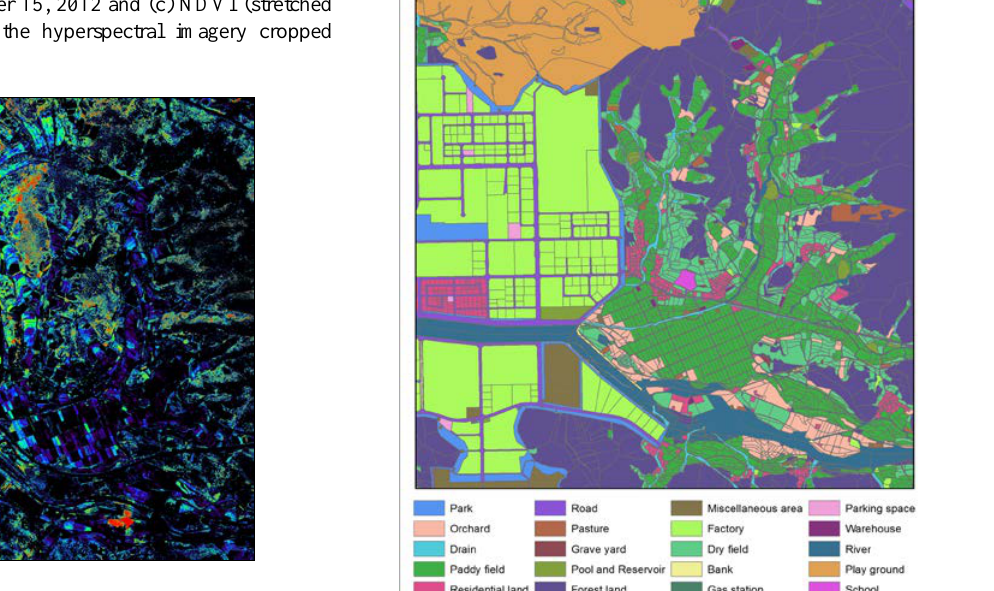
Figure 4. Differences between the NDVI values (stretched between 0.1 and 0.4 of difference values) from the aerial photographs (red colour indicates higher differences and blue colour indicates lower differences)